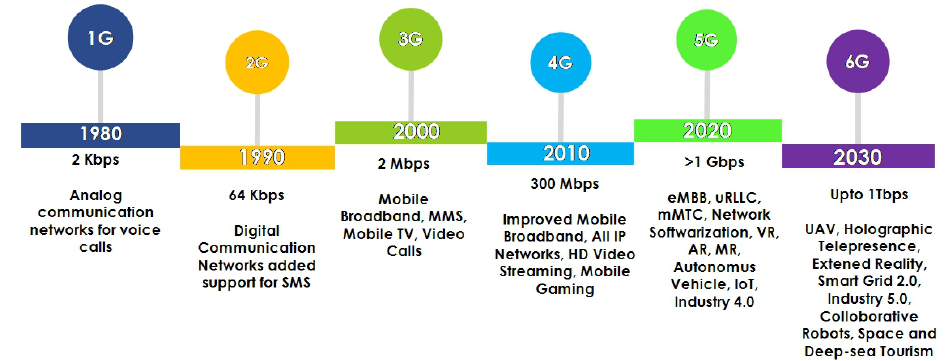
Figure 1. Evolution of wireless